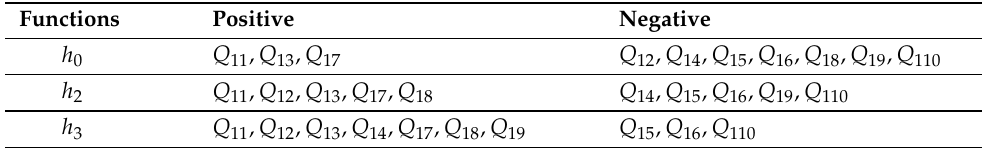
Figure 32. The ten subregions inside the region Q 1 of the Poincaré ball. Table 10. Signs of functions h 0 , h 2 and h 3 in the subregion of Q 1 .